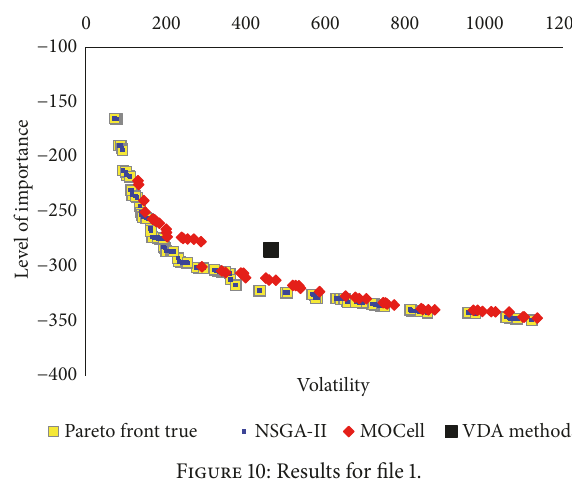
Figure 10: Results for file